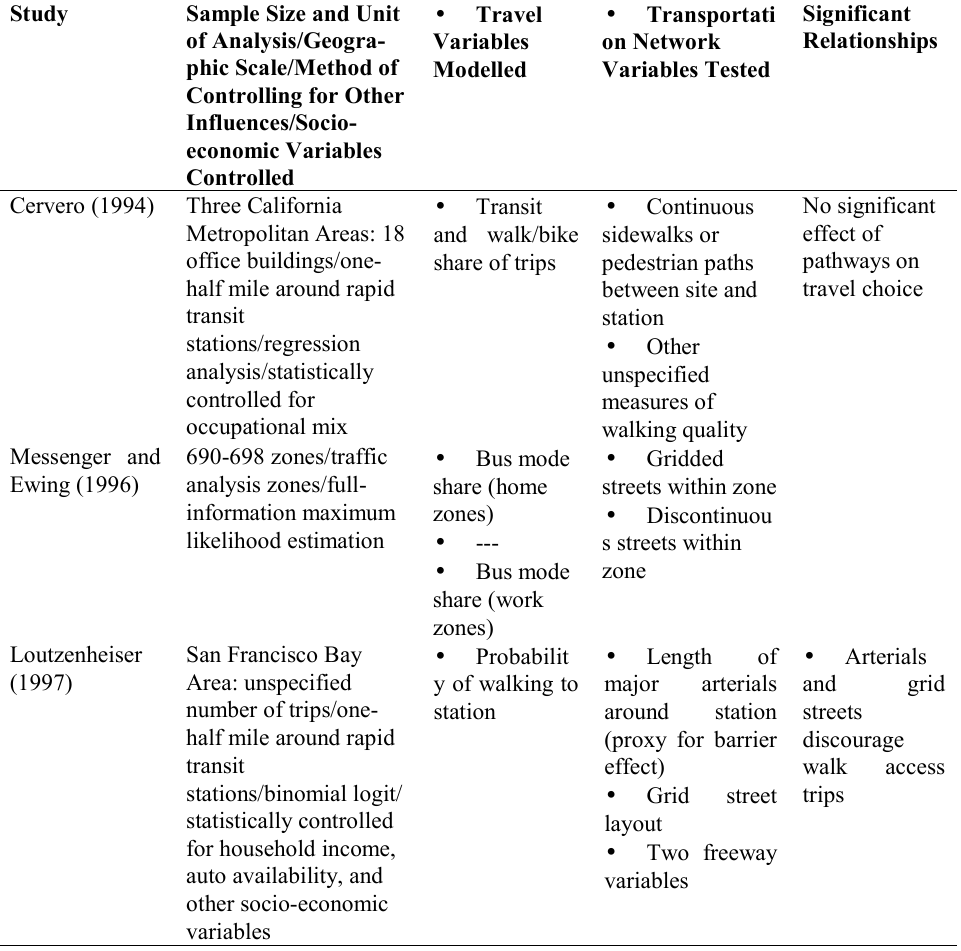
Table 6. Studies Testing Road Network